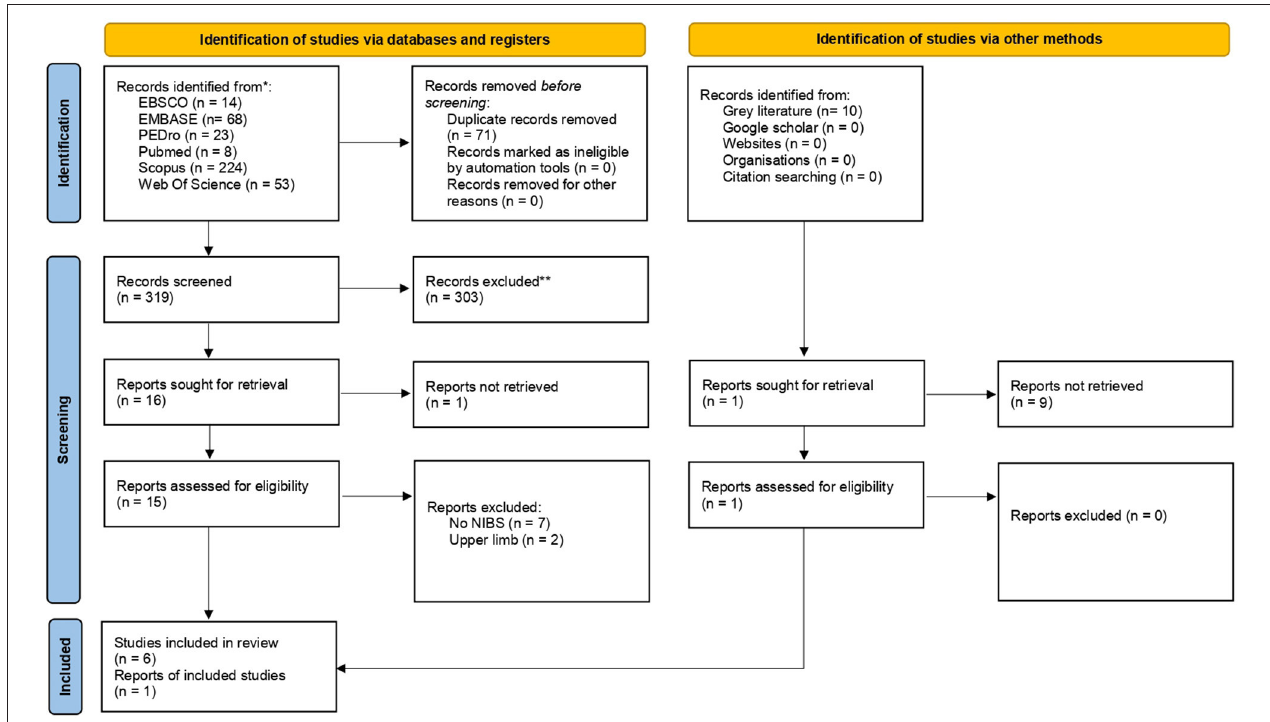
FIGURE 1 | PRISMA 2020 flow diagram for new systematic reviews which included searches of databases, registers and other sources. From Page et al. (23).